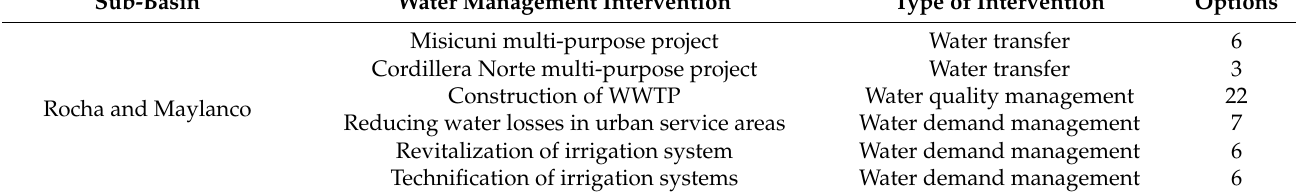
Table 2. Summary of intervention actions (L) identified to improve water management in the Rocha River Basin.